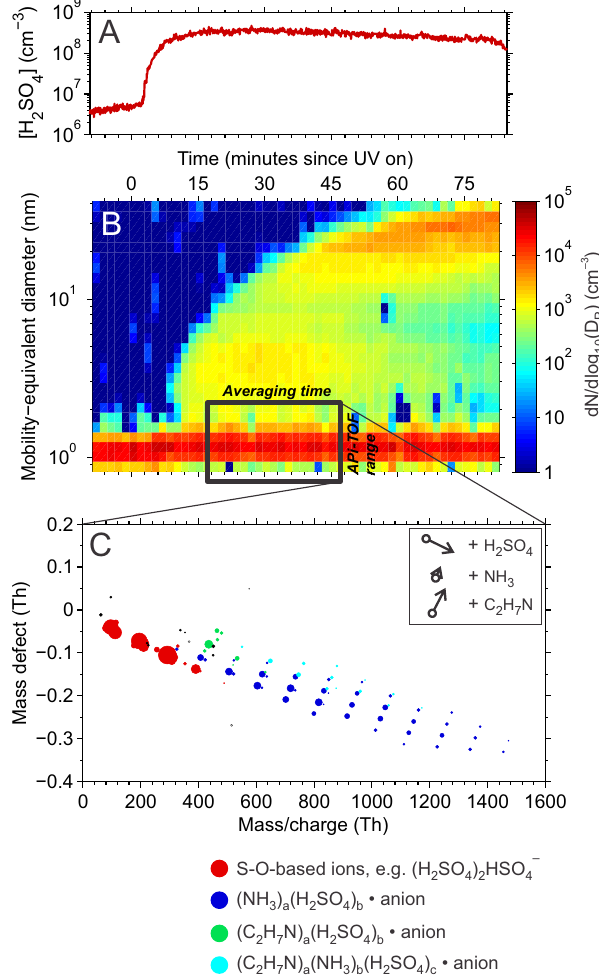
Figure 2. Summary of a typical new-particle formation experi- ment in the CLOUD chamber during the CLOUD 2 campaign, with no added NH 3 , at 20 ◦ C, 60% relative humidity, 3.7 × 10 8 cm − 3 [H 2 SO 4 ] (15pptv), estimated 4pptv [NH 3 ] (none added), <1pptv [C 2 H 7 N], pion beam on. (a) Measurements of sulfuric acid con- centration ([H 2 SO 4 ]) by CIMS, showing the marked increase in [H 2 SO 4 ] after the start of UV illumination. (b) Consequent new- particle formation event as observed by the NAIS negative ion chan- nel, showing negatively charged ions that grow from originally well below 2nm to larger sizes. The black box marks the time period of steady new-particle formation that was used for averaging APi- TOF data, and the size range covered by the APi-TOF mass spec- tra. (c) Mass defect diagram for the APi-TOF mass spectrum, aver- aged over the shown particle formation event. The diagram reveals the composition of the growing negatively charged ions between about 1 and 2nm. These are ion clusters, growing by the addition of H 2 SO 4 and contaminant NH 3 molecules (red and blue). Some clusters also contain contaminant amines (green and light